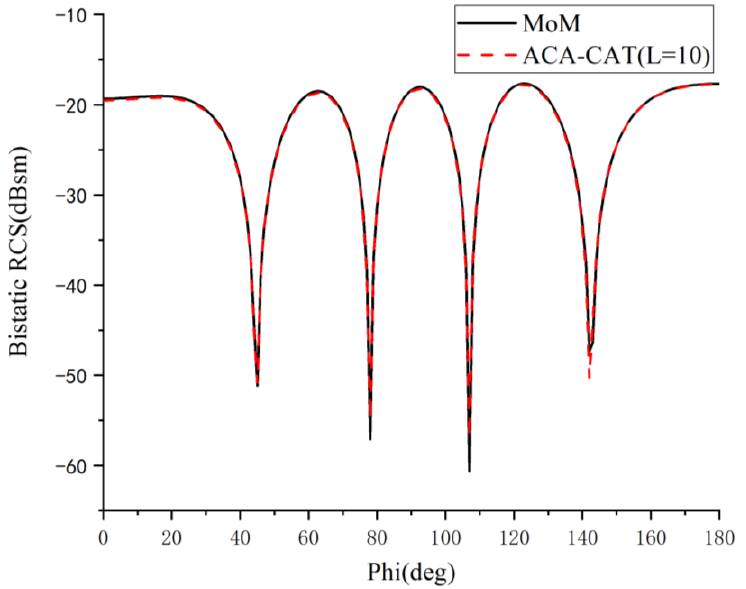
Figure 15. Bistatic RCS for the dual missile model using MoM and ACA-CAT of the non-Gaussian sampling points. sampling points.